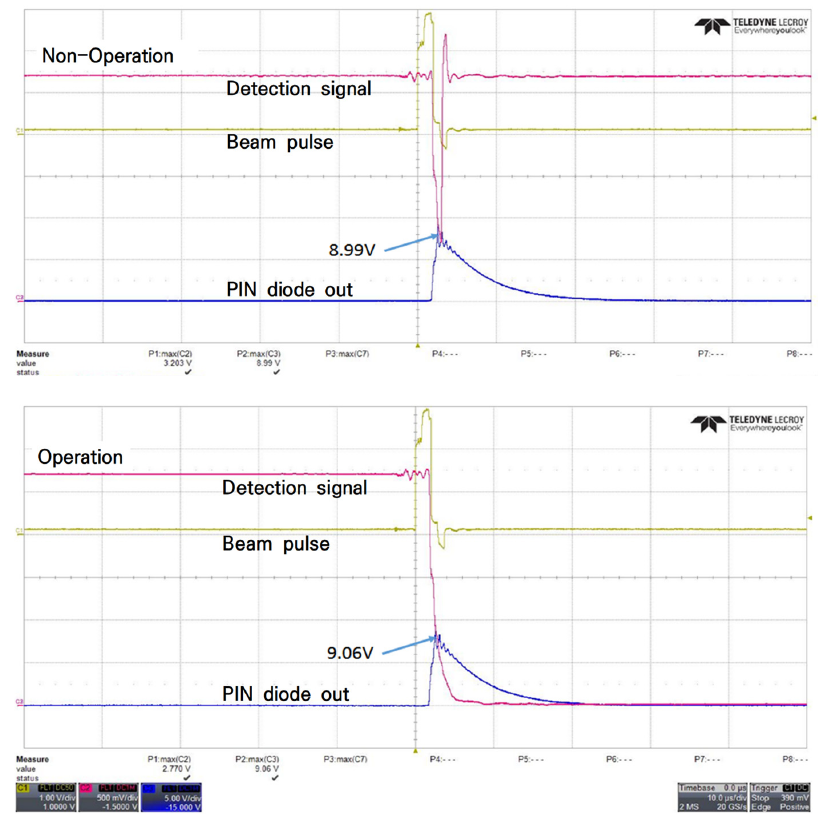
Figure 17. Detection function measurement outcome according to the dose of the proposed pulsed- radiation detection circuit (@ 2.0 × 10 7 rad(si)/s).